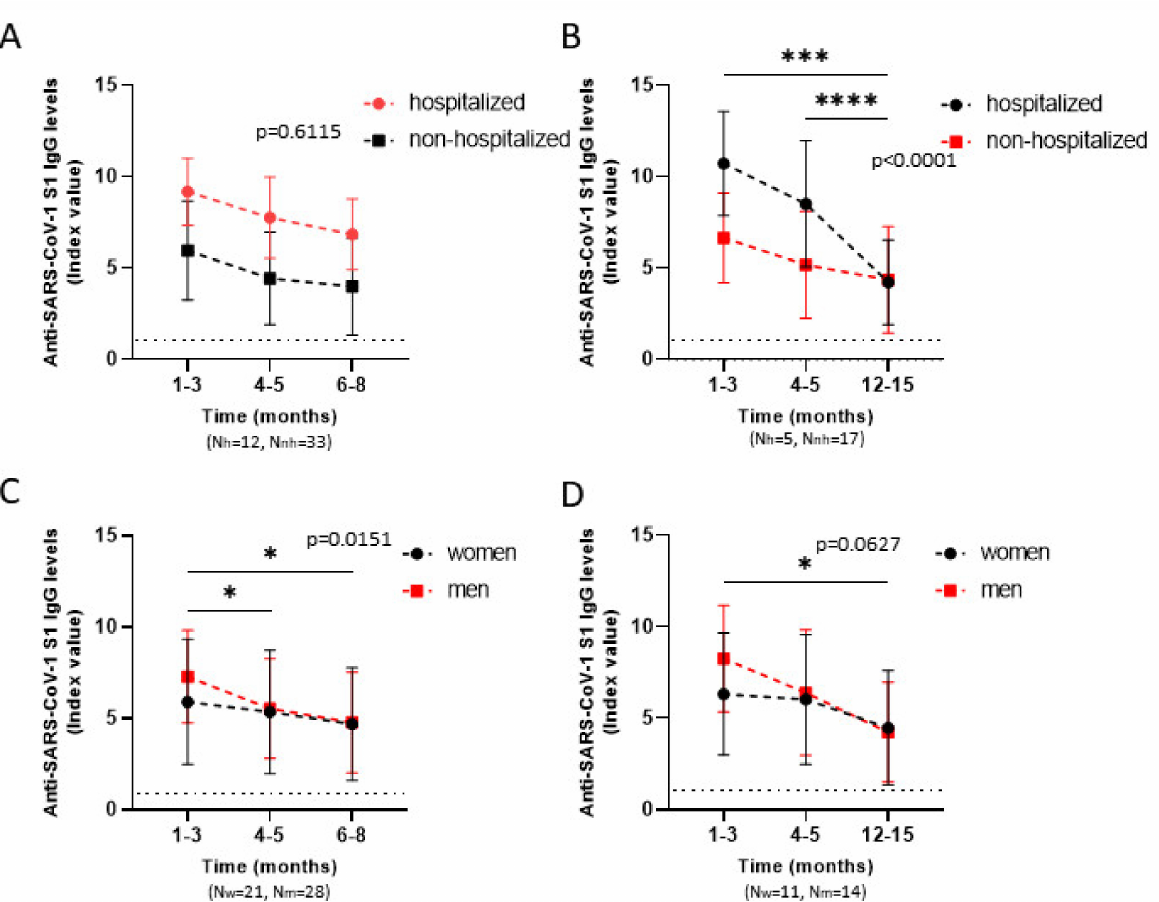
Figure 5. Comparison of IgG responses targeting SARS-CoV-2 S1 between female and male patients and between hospitalized and non-hospitalized patients in relation to time. IgG responses were measured at various time-points and grouped into categories regarding their sex and their clinical features. Patients whose last sample was collected six to eight months or twelve to fifteen months after infection were analyzed separately. Repeated measures two-way ANOVA with the Geisser– Greenhouse correction was performed to determine whether the difference between the groups analyzed (hospitalized vs. non-hospitalized and men vs. women) is identical: (a) among all time- points tested and the p values extracted from this analysis are displayed on the panels, or (b) between two time-points at a time and the respective p values extracted are * p < 0.05, *** p < 0.001, and **** p < 0.0001. Horizontal dashed lines represent the cut-off value of the assay used. Comparison of anti-SARS-CoV-2 IgG titers between hospitalized and non-hospitalized individuals, ( A ): whose last samples is collected six to eight months after infection. ( B ): whose last samples is collected twelve to fifteen months after infection. Between female and male patients, ( C ): whose last samples is collected six to eight months after infection. ( D ): whose last samples is collected twelve to fifteen months after